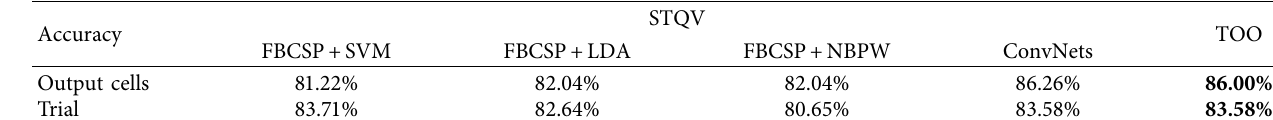
Figure 6: Six convolutional layers of the TOO model structure. Table 1: The accuracy of TOO and STQV.